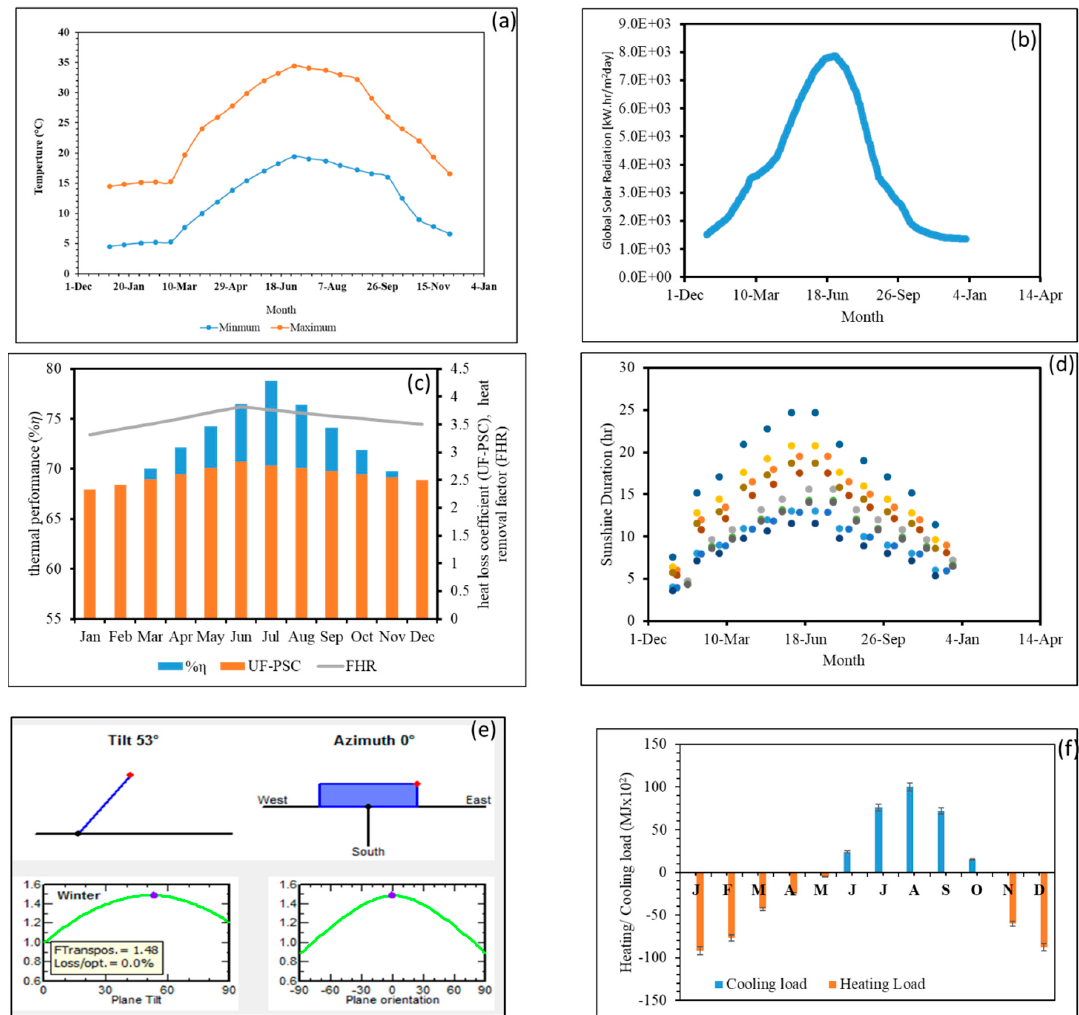
Figure 1. ( a ) Minimum and maximum ambient temperature distribution during different months in the study area (Mafraq); ( b ) The average daily solar irradiation intensity profile (SII avg.,d ) in the study area (Mafraq); ( c ) Thermal performance (% η ) the overall heat loss coefficient (U F-PSC ), and heat removal factor (F HR ) for the F-PSC; ( d ) Average number of sunny hours (t sun,m ) per month for the study area, ( e ) Optimization of tilt and azimuth angles of the solar collectors and ( f ) monthly average heating/cooling loads of the building.